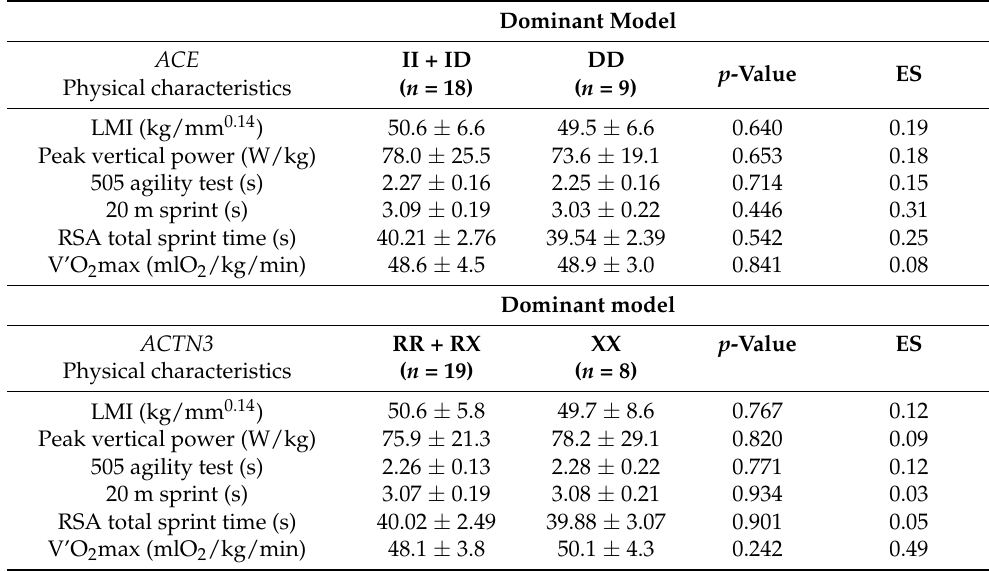
Table 4. Physical characteristics of elite rugby union players; relative to ACE , ACTN3 , and MCT1 genotypes according to the dominant